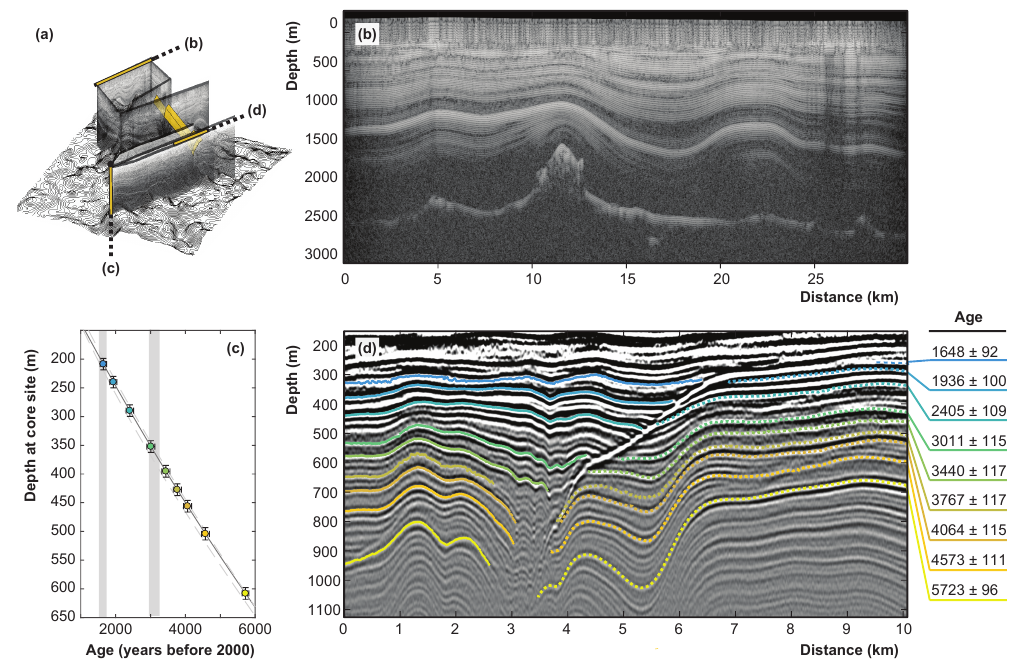
Figure 2. (a) Fence diagram, indicating the positions of the upstream radar survey (b) , the Byrd ice core (c) , and an example downstream line containing the unconformity of interest (d) . (b) The radar profile immediately upstream of Mt. Resnik, highlighting conformable layering. (c) Dated reflectors and their associated uncertainties, plotted as a function of depth at the Byrd ice-core site. Grey bars indicate dated slope breaks in the unconformity, potential indications of historic ice-dynamic changes (discussed in Sect. 3.2). (d) Dated reflectors traced on the 3MHz ITASE radargram, with ages (in years before 2000AD) labeled. Dotted lines indicate reflectors dated by amplitude and waveform correlation across the unconformity; solid lines are traced continuously from the ice-core